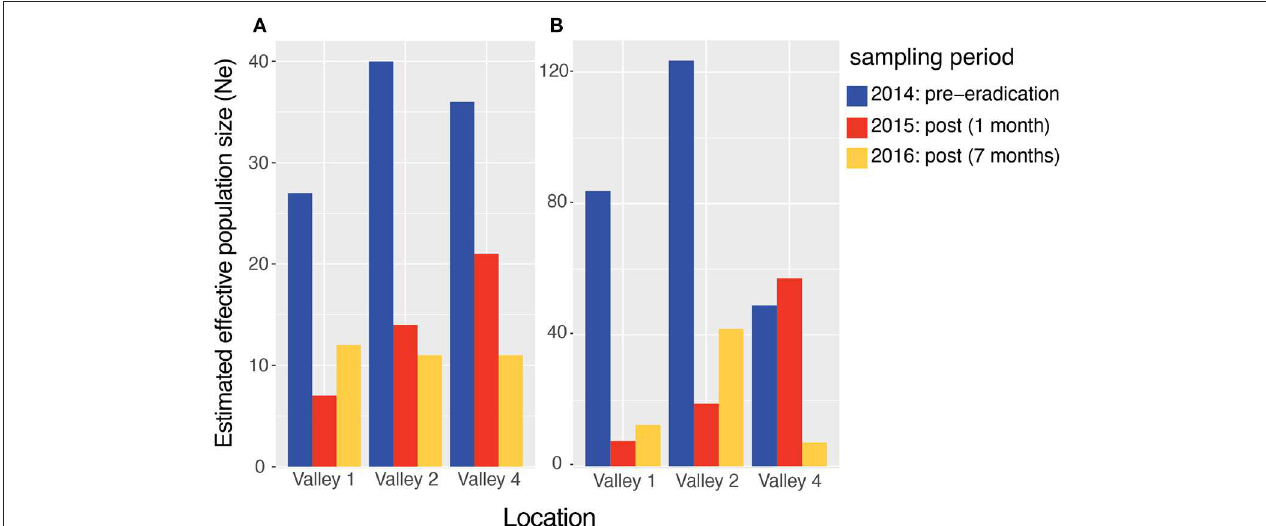
FIGURE 2 | Point estimates of effective population size ( N e ) in three valleys of the Pau da Lima area of Salvador, Brazil. 241 rats were sampled just before the city conducted an eradication campaign to reduce the rat population (late-2014, blue bars), 1 month following the campaign (2015, red bars), and then 7-months later (early-2016, gold bars). Ne was estimated using two different methods: (A) the sibship frequency and (B) linkage disequilibrium approaches. Full data can be found in Table S1 .